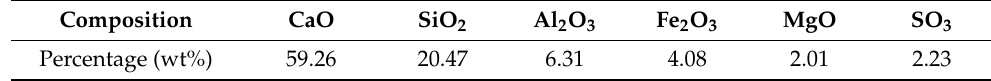
Table 2. The main chemical compositions of cement.